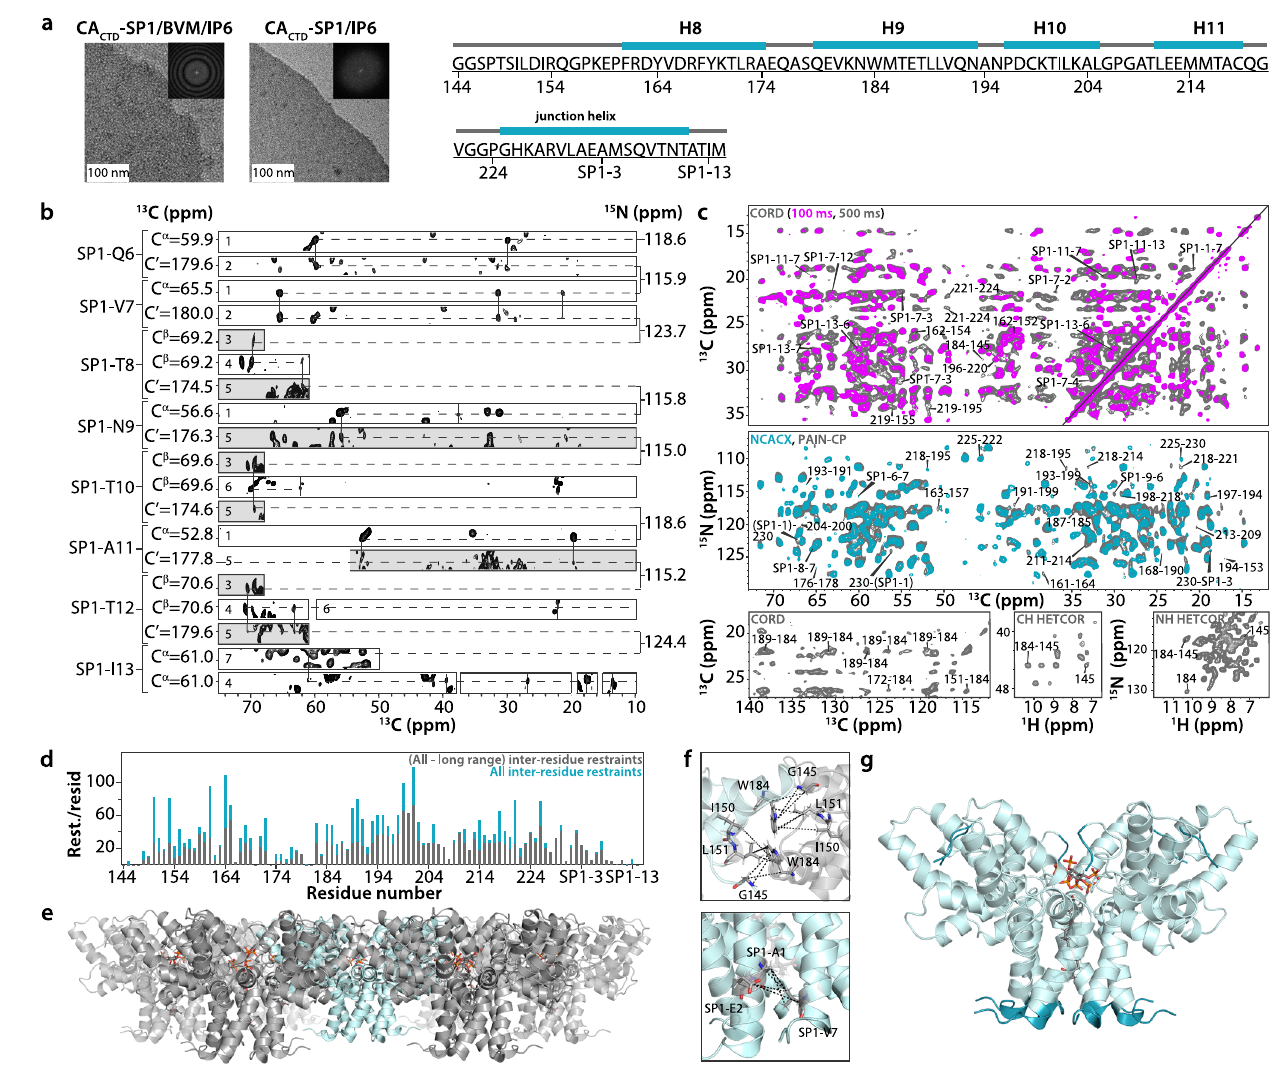
Fig. 1 | MAS NMR spectra and structure of CA CTD -SP1 crystalline array. a Negative stainTEM imagesofCA CTD -SP1 microcrystalsassembled withIP6,inthe presence (left) or absence of BVM (middle). Insets show the computed Fourier transforms of the images, indicating the expected hexagonal lattices and unit cell spacings. The scale bars are 100nm. Amino acid sequence of CA CTD -SP1 (right). b Representative strips of 3D and 2D MAS NMR spectra of U- 13 C, 15 N-CA CTD -SP1/ BVM/SO 4 (white strips) and U- 13 C, 15 N-CA CTD -SP1/IP6 (gray strips) crystalline arrays, illustrating sequential assignments for SP1 residues Q6-I13. The MAS NMR spectra are labeled as follows: 3D NCACX (1), 3D NCOCX (2), 2D NCACX at − 79°C (3), 2D INADEQUATE (4), 2D NCOCX at − 79°C (5), 2D CORD (6), 2D NCACX (7). No sig- ni fi cant chemical shift perturbations were detected for the free vs. BVM- or IP6- bound samples (see Supplementary Fig. 3). c Top panel: Superposition of selected regions of 2D CORD spectra of U- 13 C, 15 N-CA CTD -SP1/BVM/IP6 crystalline arrays for different mixing times: 100ms (magenta) and 500ms (gray). Middle panel: